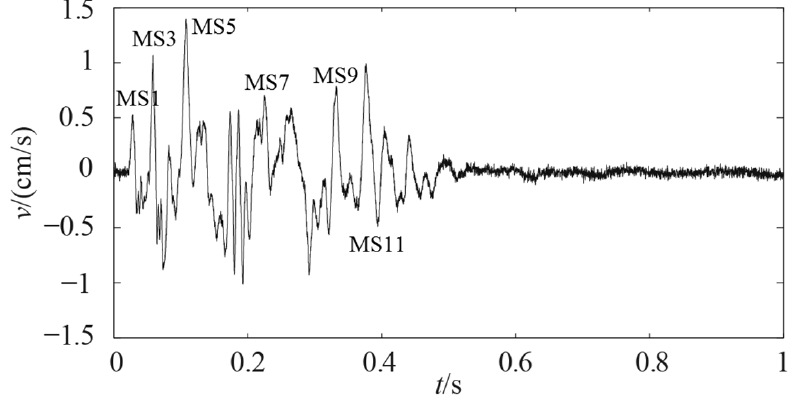
Figure 2. Blasting seismic wave signal (s1).